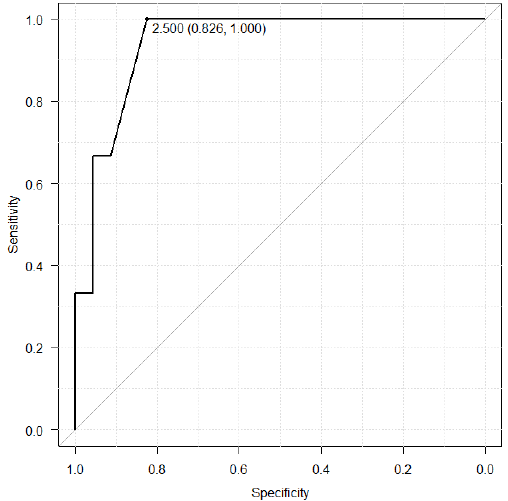
Figure 3. Receiver operating characteristic (ROC) curve between serum albumin level before TZD treatment and hyponatremia.